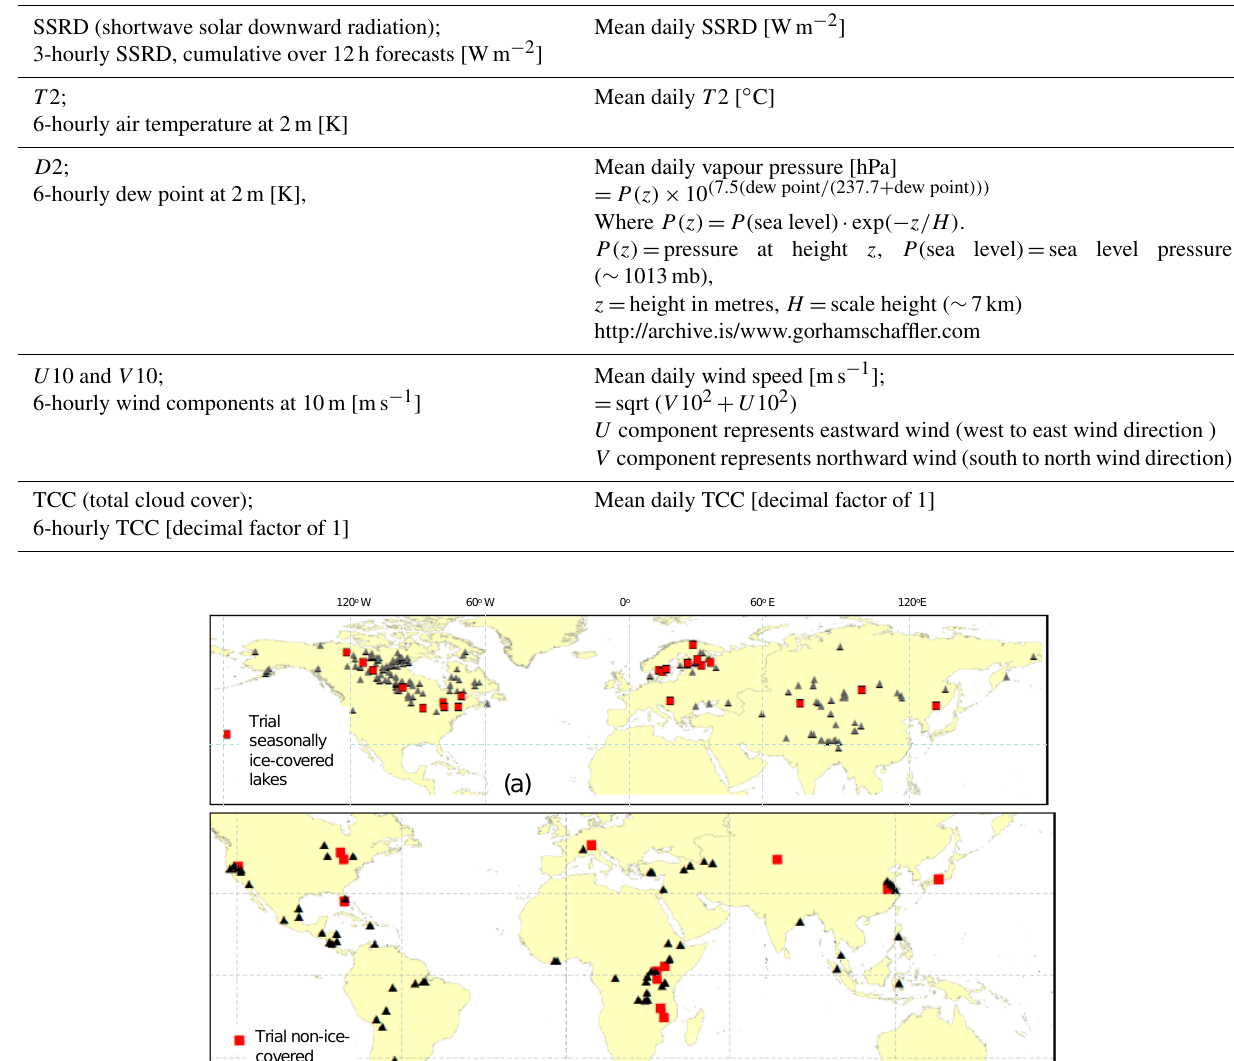
Table 1. ECMWF Interim Re-analysis (ERA) data components and FLake input format. Units are given in square brackets. ERA data components and description FLake input